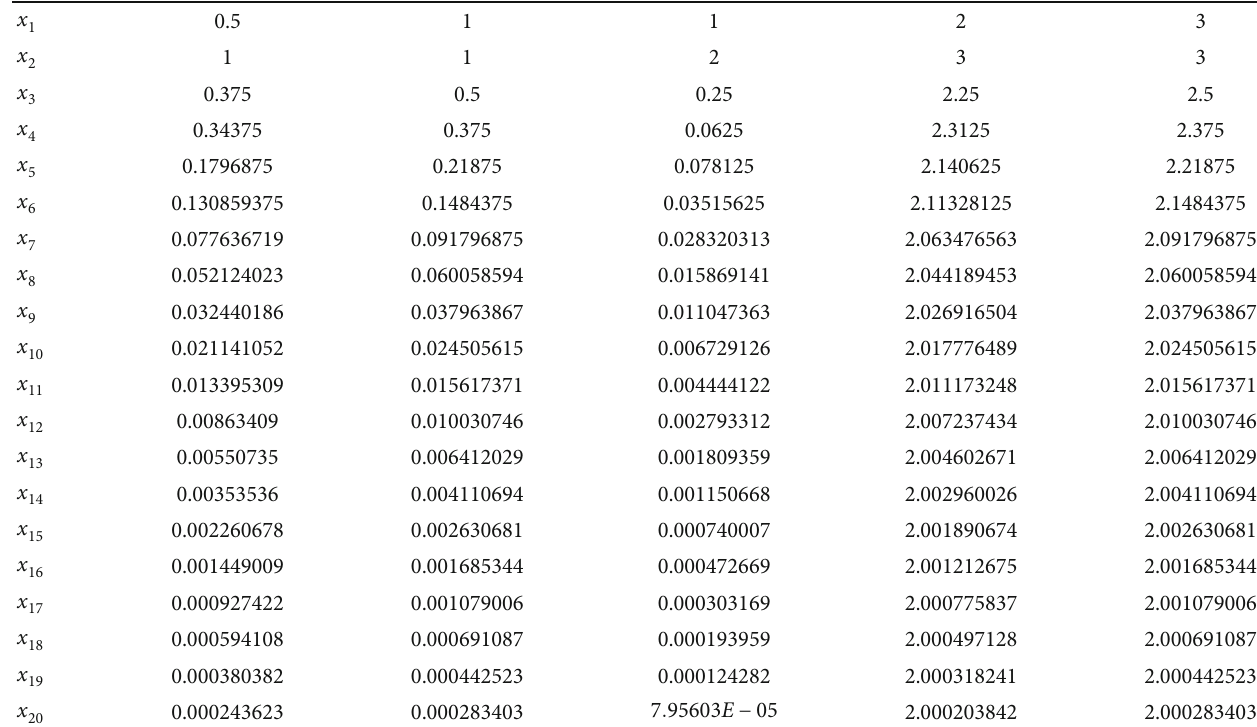
Table 1: A numerical experiment for Example